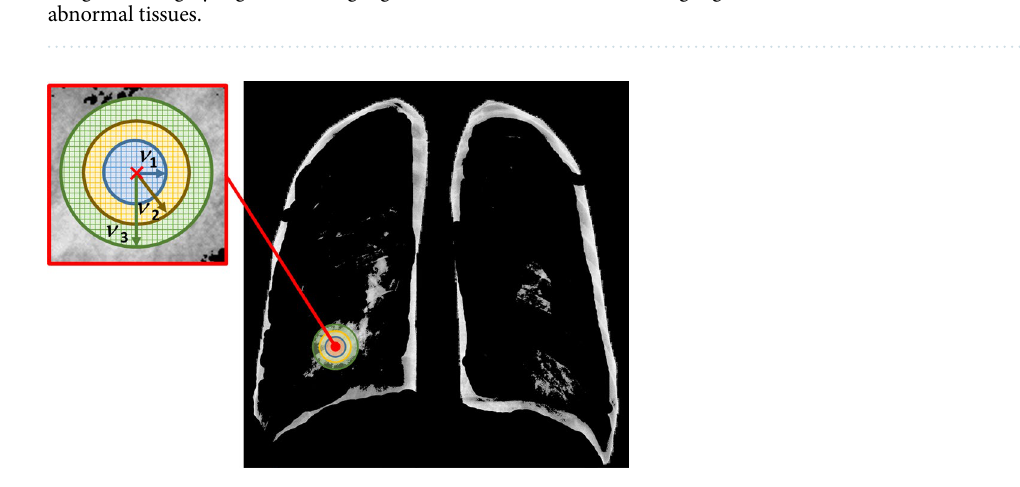
Figure 3. Illustration of rotation and translation invariant central-symmetric neighborhood sets for the three different radii (ν − 0.5, ν + 0.5 ] ; ν = 1, . . . , 3